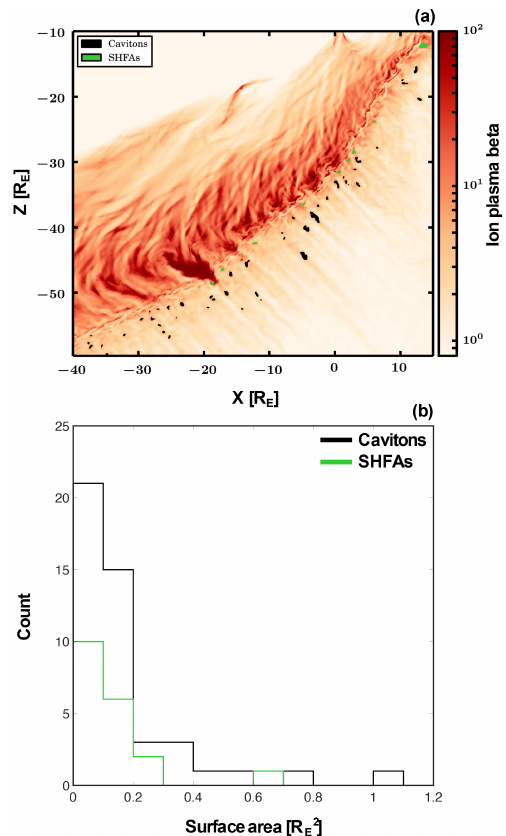
Figure 8. Spatial distribution of cavitons and SHFAs and their asso- ciated physical scales in terms of surface area. Panel (a) shows the global spatial distribution of cavitons and SHFAs at T 3 = 1350s. Cavitons and SHFAs can be identified from the black and green regions, respectively. The colour scale of the simulation run corre- sponds to ion plasma β on a logarithmic scale. Panel (b) represents a histogram of the caviton and SHFA surface areas in R 2 of cavitons and SHFAs is the same as panel (a)